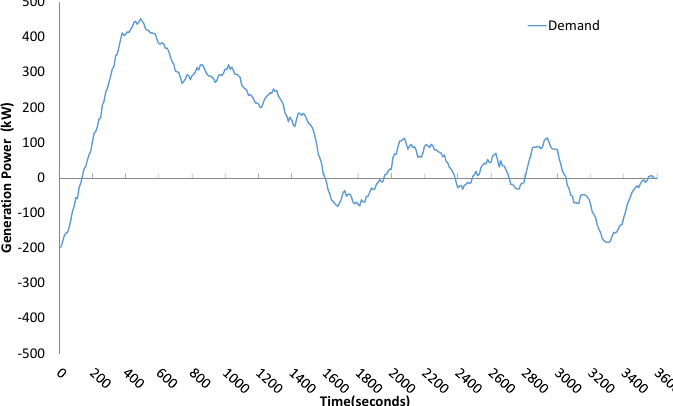
Figure 8. Set points fixed by the electricity grid operator that the generation plant should